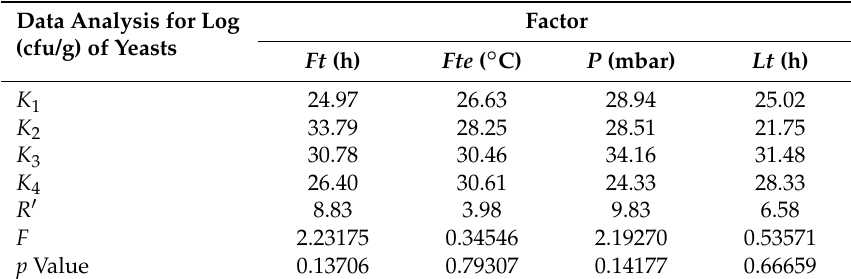
Table 8. Data analysis of dried MKG log (cfu/g) of yeasts.